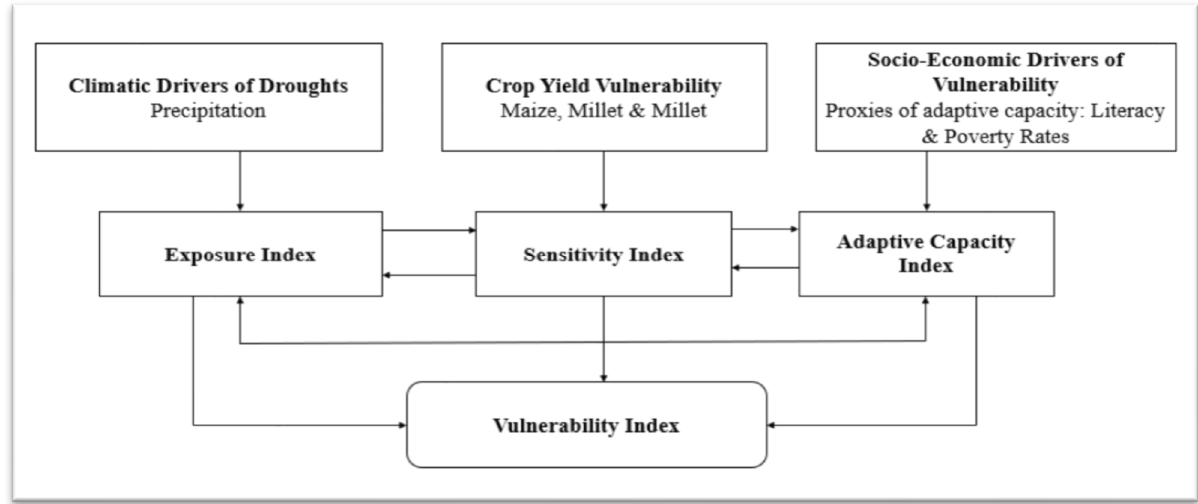
Figure 1. Schematic Representation of the Vulnerability Index. Table 1. Other vulnerability indices.